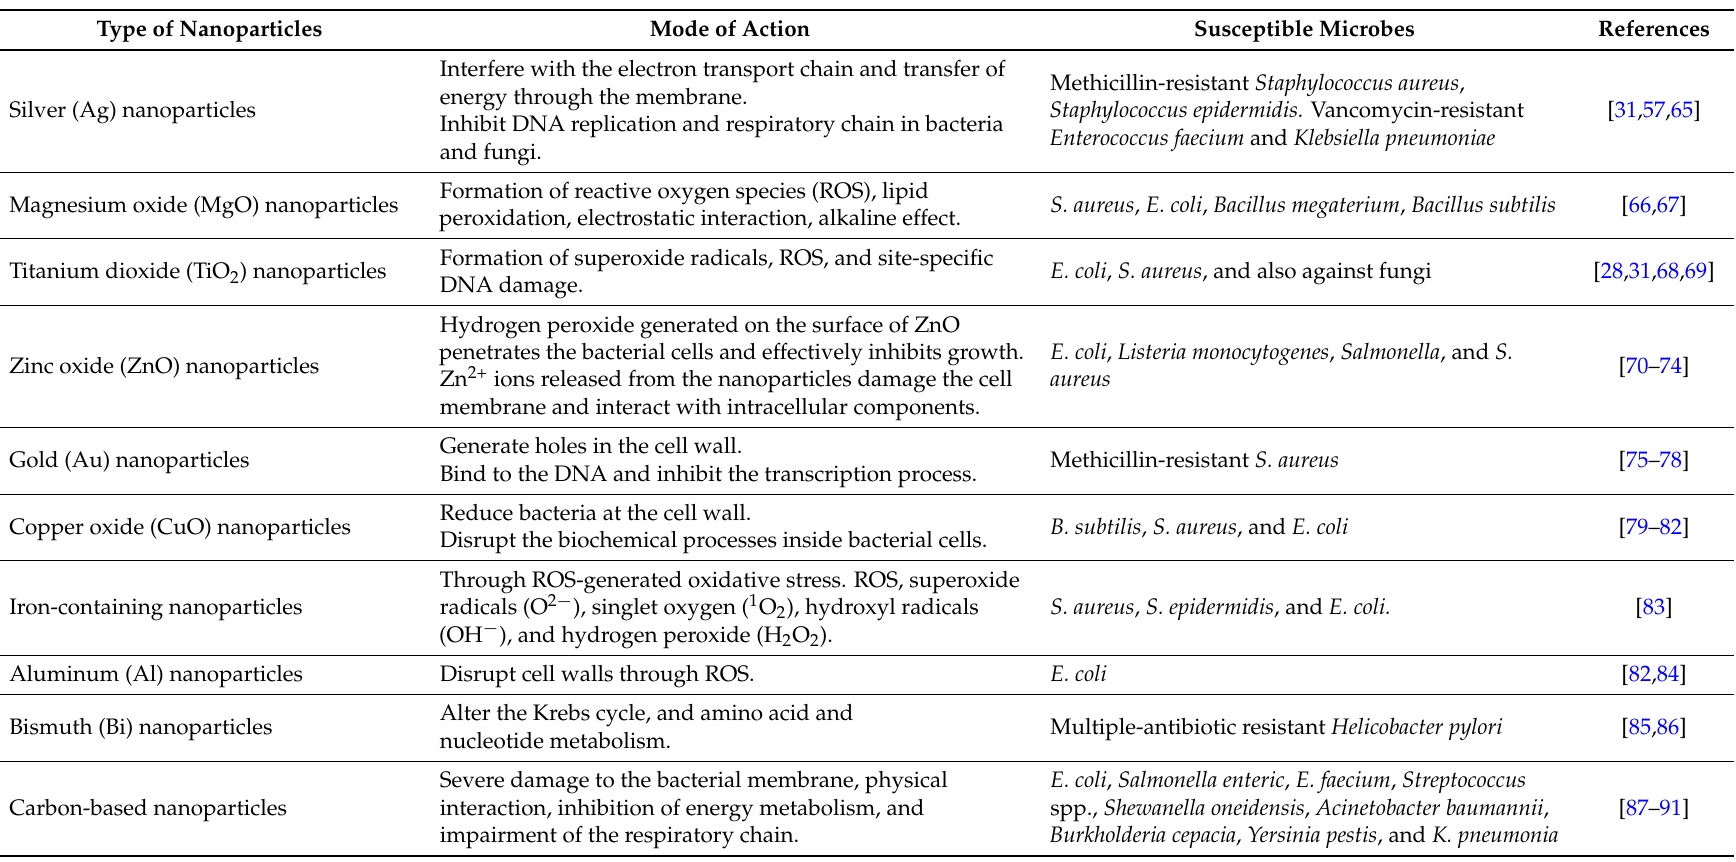
Table 1. Mode of action of various nanoparticles/nanocomposites against pathogenic